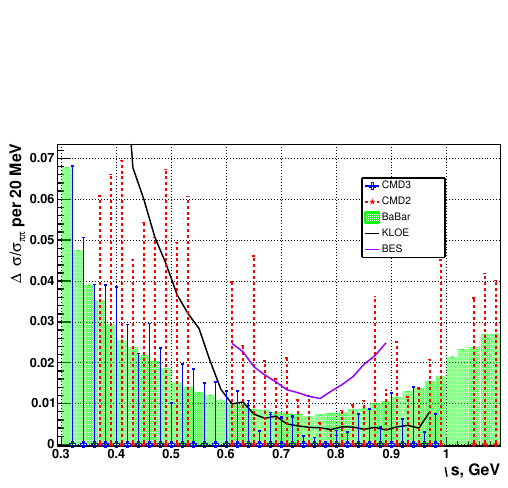
| 2 from the CMD- π